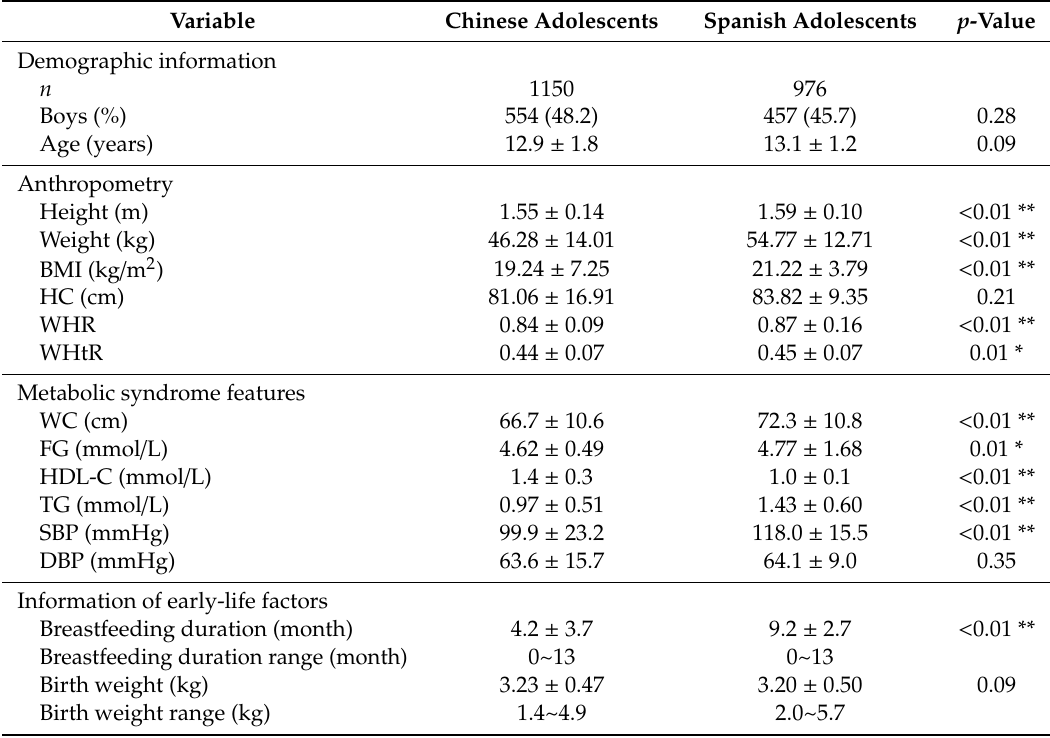
Table 1. Demographic and clinical characteristics of Chinese and Spanish